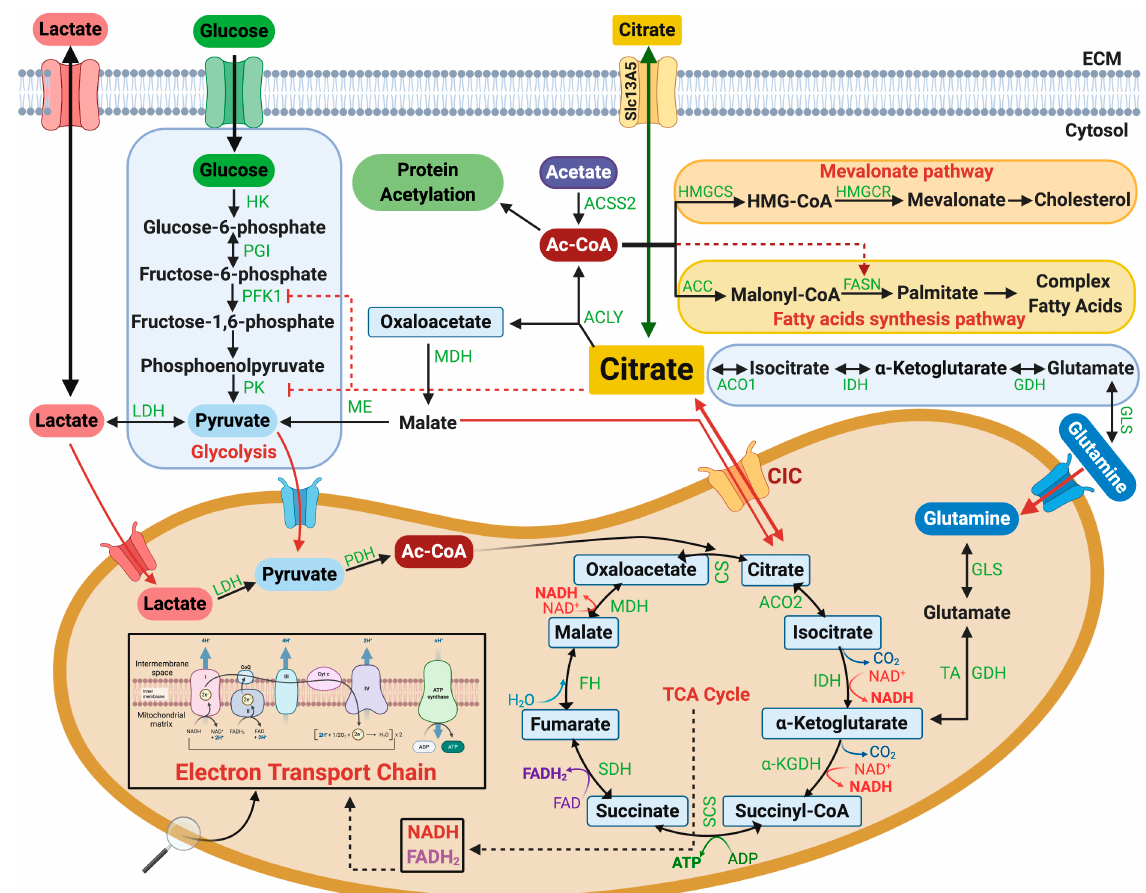
Figure 4. Pathways to the generation of cytosolic and mitochondrial citrate and its utilization. Glucose-derived citrate is obtained through the conversion of glucose to glucose-6-phosphate, which, with a series of enzymatic reactions, is then converted to pyruvate. Pyruvate is reduced to lactate via lactate dehydrogenase (LDH) or, alternatively, transported into mitochondria to produce Acetyl-Coenzyme A (Ac-CoA) via pyruvate dehydrogenase (PDH). Citrate synthase then catalyzes the condensation of acetyl-CoA with oxaloacetate to yield citrate that is exported in the cytosol by CIC. Lactate can also enter the mitochondria and be converted to pyruvate by a mitochondrial lactate dehydrogenase (mtLDH) regenerating citrate. Mitochondrial citrate and, to a lesser extent, lactate fuel the tricarboxylic acid (TCA) cycle and the electron transport chain (ETC). Citrate can also be uptaken from the extracellular space and transported to the cytosol via SLC13A5. In the cytosol, citrate provides Ac-CoA via ATP citrate lyase (ACLY) for protein acetylation and can enter the mevalonate pathway for cholesterol biosynthesis mediated by hydroxymethylglutaryl-CoA synthase (HMGCS) and hydroxy-3-methylglutaryl-CoA reductase (HMGCR) and the fatty acid synthetic pathway via acetyl-CoA carboxylase (ACC) and fatty acid synthase (FASN). Cytosolic Ac-CoA can be also generated by acetyl-CoA synthetase 2 (ACSS2) which converts acetate derived from deacetylation reactions to acetyl - CoA . Cytosolic citrate inhibits phosphofructokinase 1 (PFK1) and pyruvate kinase (PK), thus playing an active role in controlling glycolytic flux. An alternative source of mitochondrial or cytosolic citrate is supplied by reductive carboxylation of alpha-ketoglutarate to isocitrate, mediated in the cytosol by isocitrate dehydrogenase 1 (IDH1) and in the mitochondria by IDH2. Additional abbreviations: